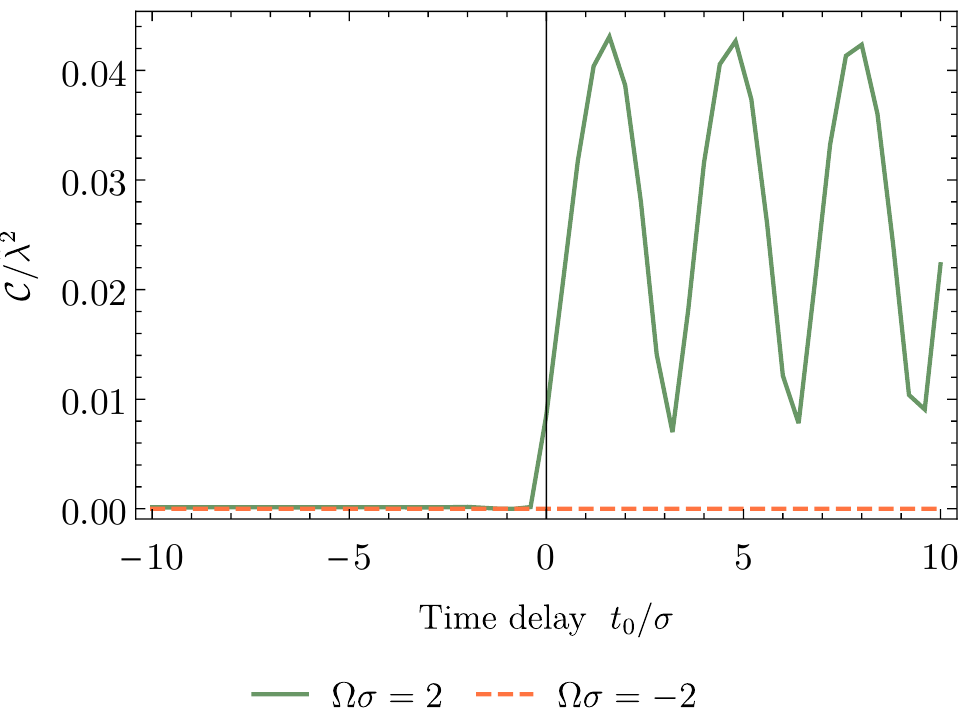
Figure 11 . The concurrence, C = ~ (cid:21) associated with the state (cid:26) AB of the two detectors as a function of the relative time delay in their switching functions t 0 =(cid:27) for an AdS length of ‘=(cid:27) = 1, a detector separation of d ( R A ; R B ) = 5 (cid:27)= 2, Neumann boundary conditions ( (cid:16) = (cid:0) 1) and an energy gap of (cid:10) (cid:27) = 2 and (cid:10) (cid:27) = (cid:0) 2.